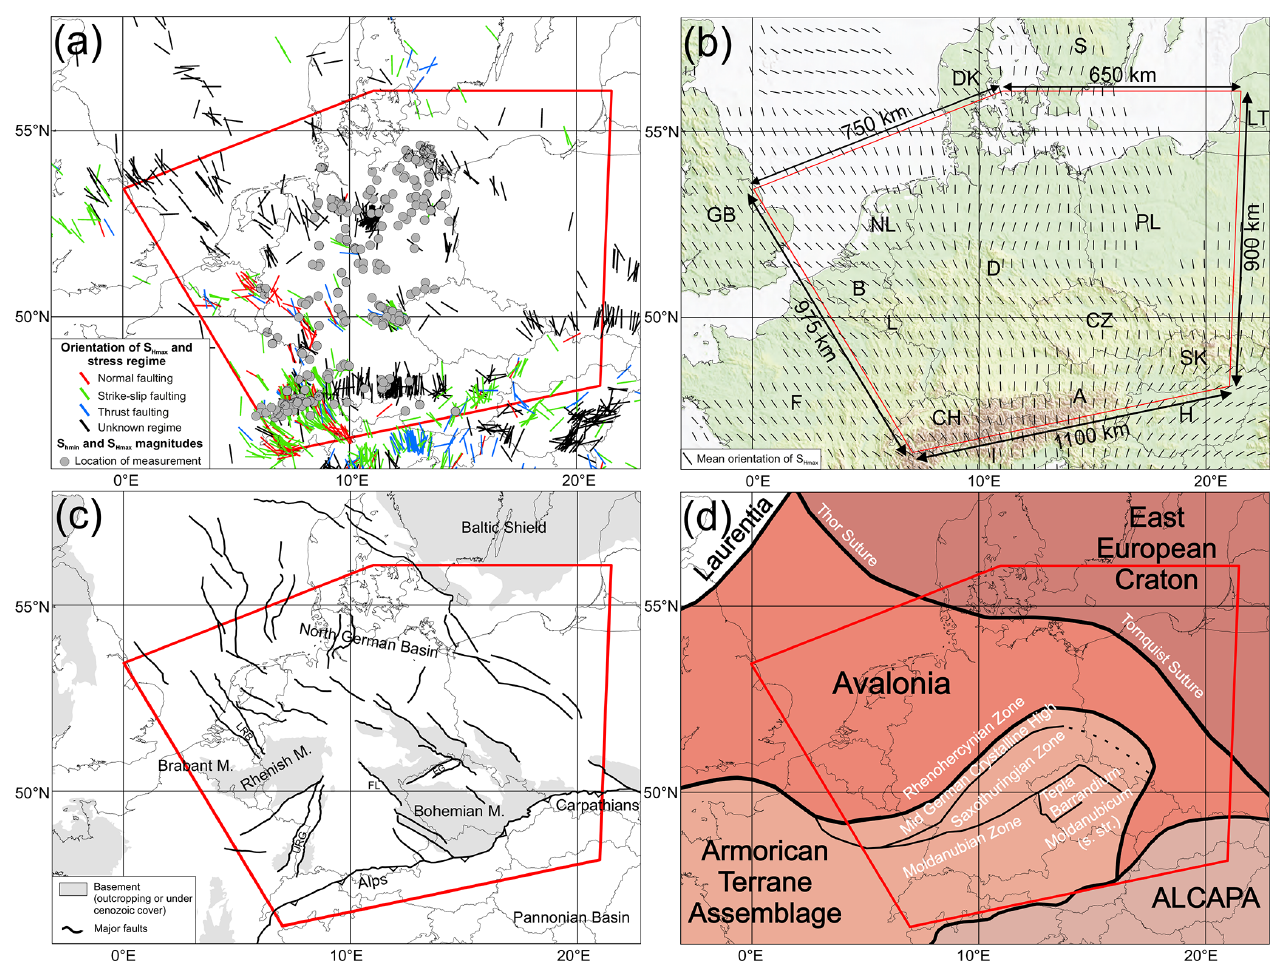
Figure 1. Maps of western central Europe. The red polygon indicates the model area. (a) Overview of calibration data used. Color-coded lines indicate the orientation of S Hmax and the stress regime of the WSM (Heidbach et al., 2016) and additional data of Levi et al. (2019). Grey dots show the positions of stress magnitude data of Morawietz and Reiter (2020). (b) Topography and mean S Hmax orientations on a regular 0.5 ◦ grid derived from the WSM. Each grid point requires at least 10 data points within a fixed search radius of 200km (details in Sect. 4.1). The topography is based on Smith and Sandwell (1997). (c) Tectonic framework of the model area based on Asch (2005) and Kley and Voigt (2008). EG – Eger Graben, FL – Franconian Line, LRB – Lower Rhine Basin, M – Massif, URG – Upper Rhine Graben. (d) Overview of the crustal units in central Europe (modified after Kroner et al., 2010; Brückl et al., 2010). Black titles show tectonic units and white titles sutures and Variscan units. Coastlines and borders used in the figures are based on the Global Self-consistent Hierarchical High-resolution Geography (GSHHG) of Wessel and Smith